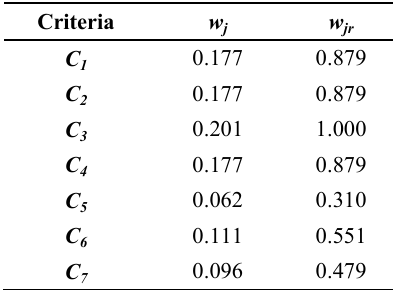
Table 6. Relative weights of the